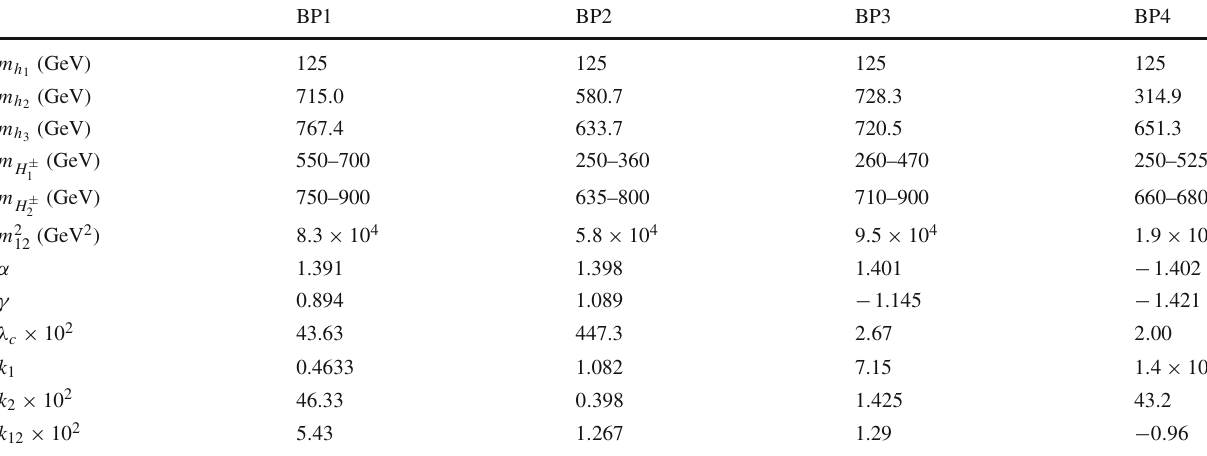
Table 2 Model parameters of the four benchmark points. We also took β (cid:7) α within a variation of